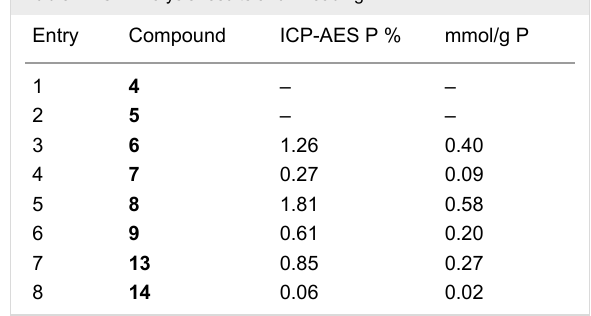
Table 1: ICP-Analysis results and P